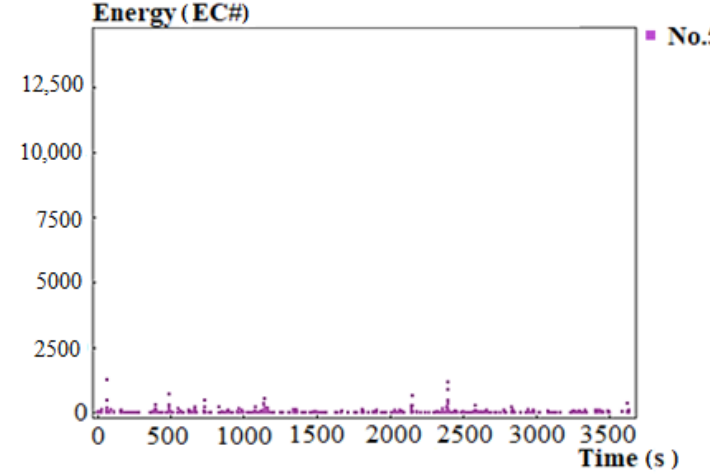
Figure 8. Energy ‐ time relationship for stringer 2 in the span 1 with the numbers of signal classes marked.